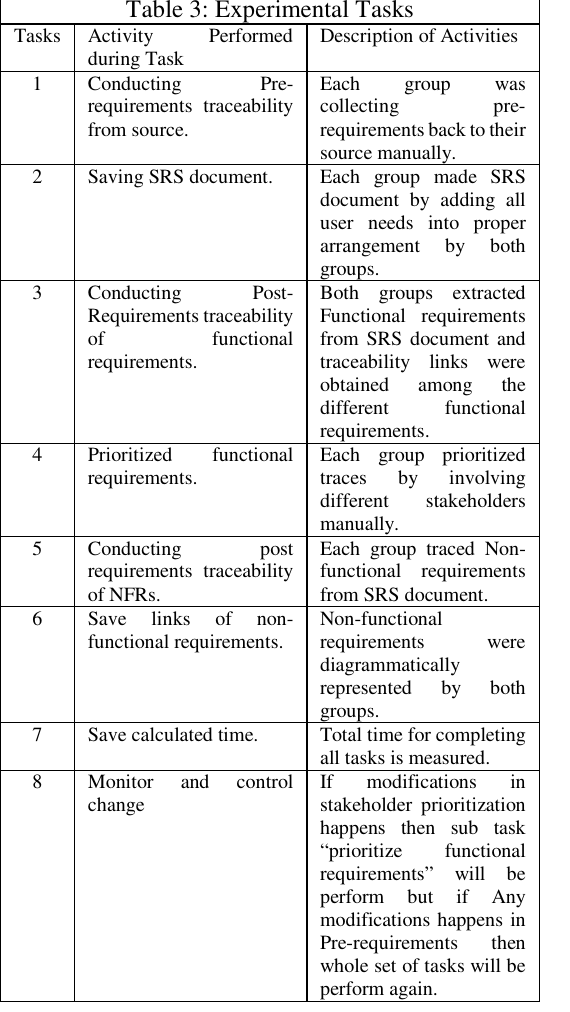
Table 3: Experimental